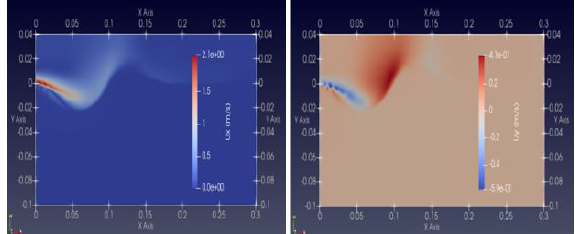
Figure 6: 2D numerical results of the water flow jet downstream of the sluice gate of aperture b 0 = 1 cm (left: U x and right: U y ).